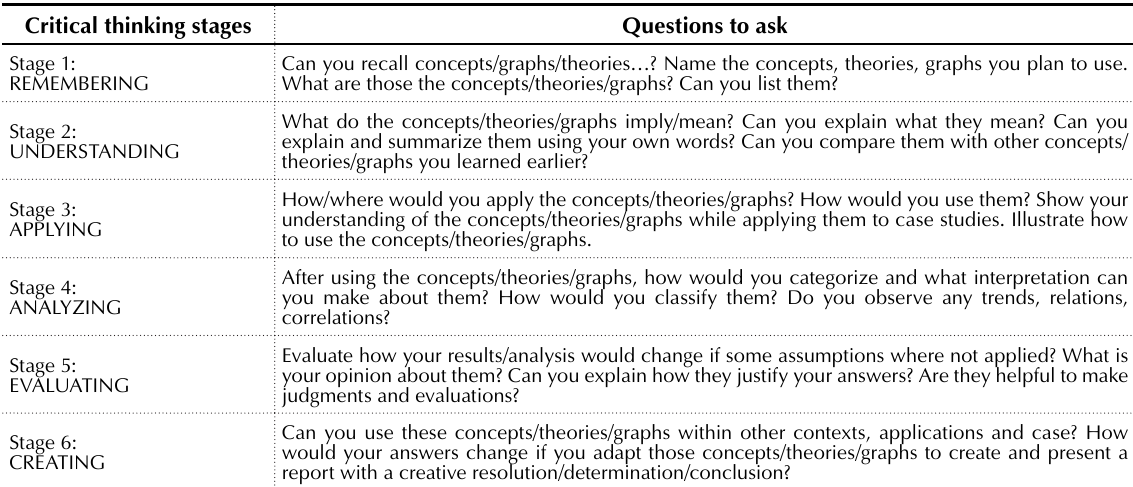
Table 2. Six stages of critical thinking and development of projects and